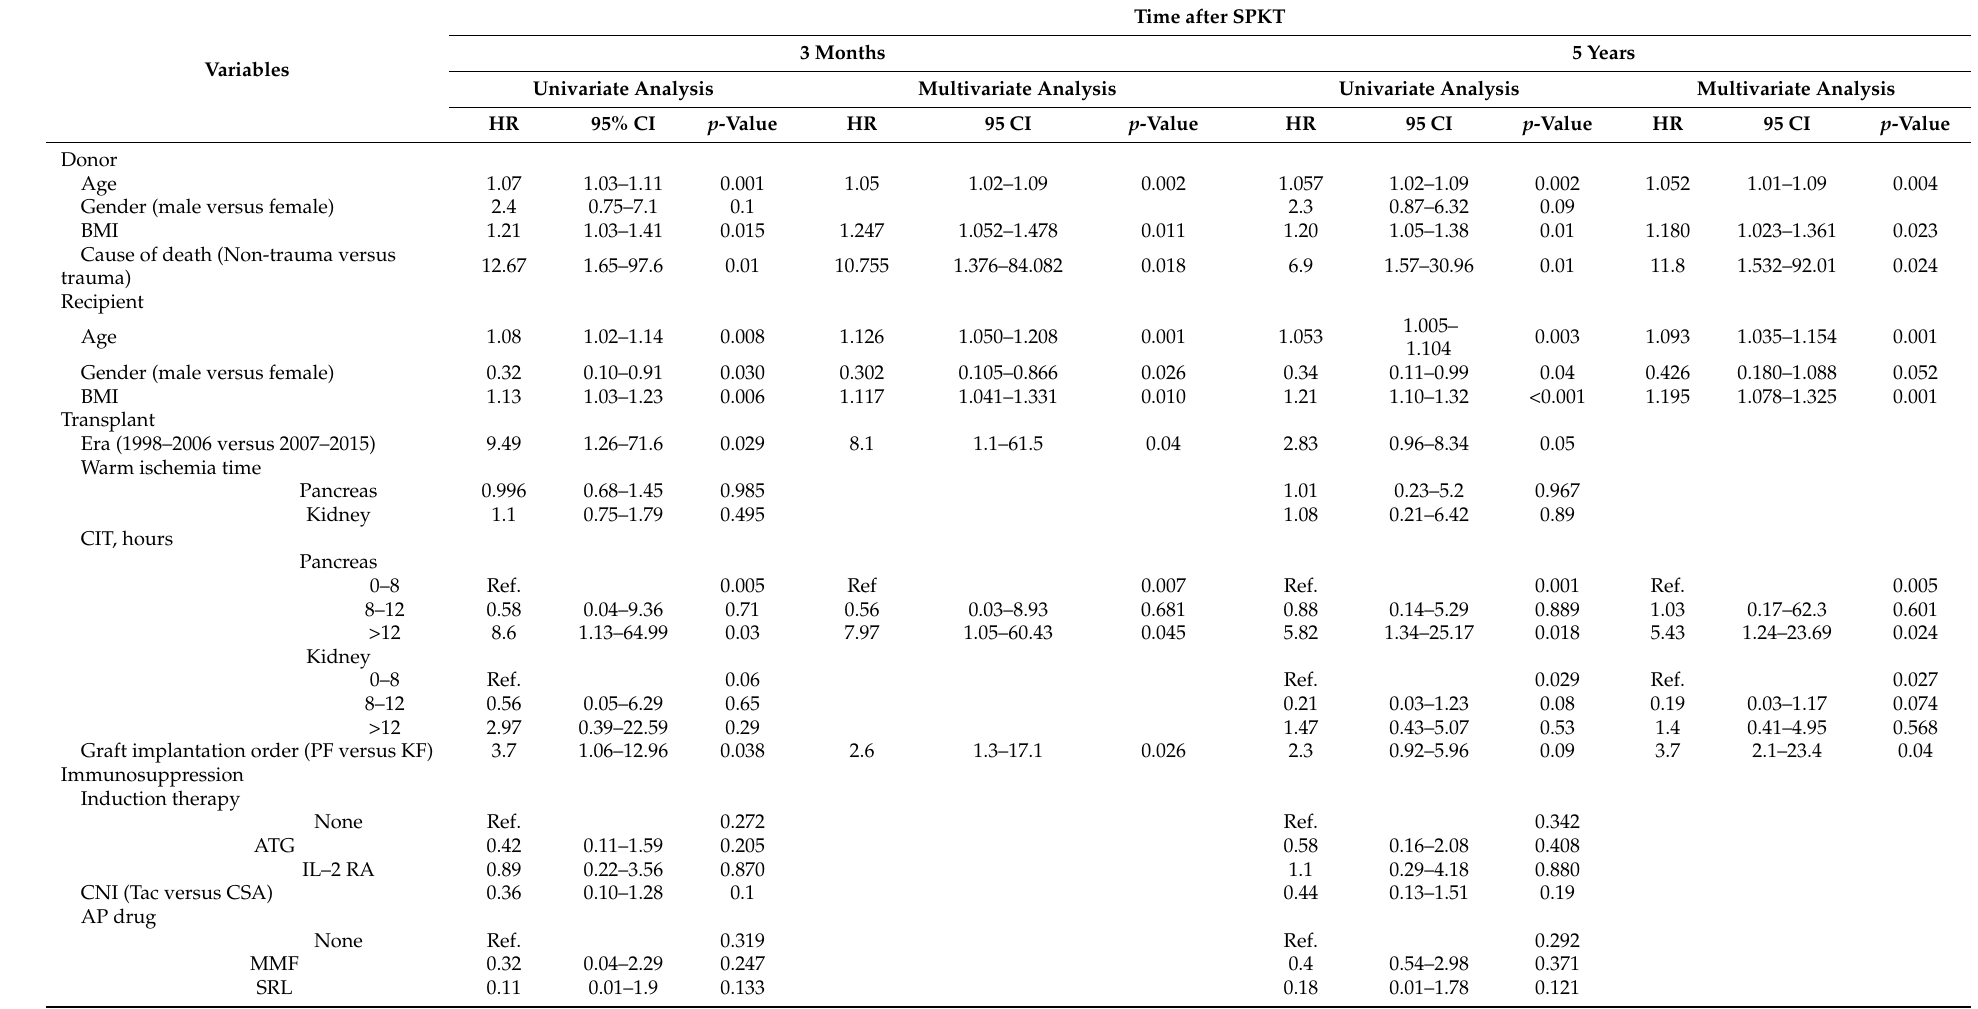
Table 3. Multivariate Cox regression analysis of predictors of pancreas graft loss three months and five years after simultaneous pancreas-kidney